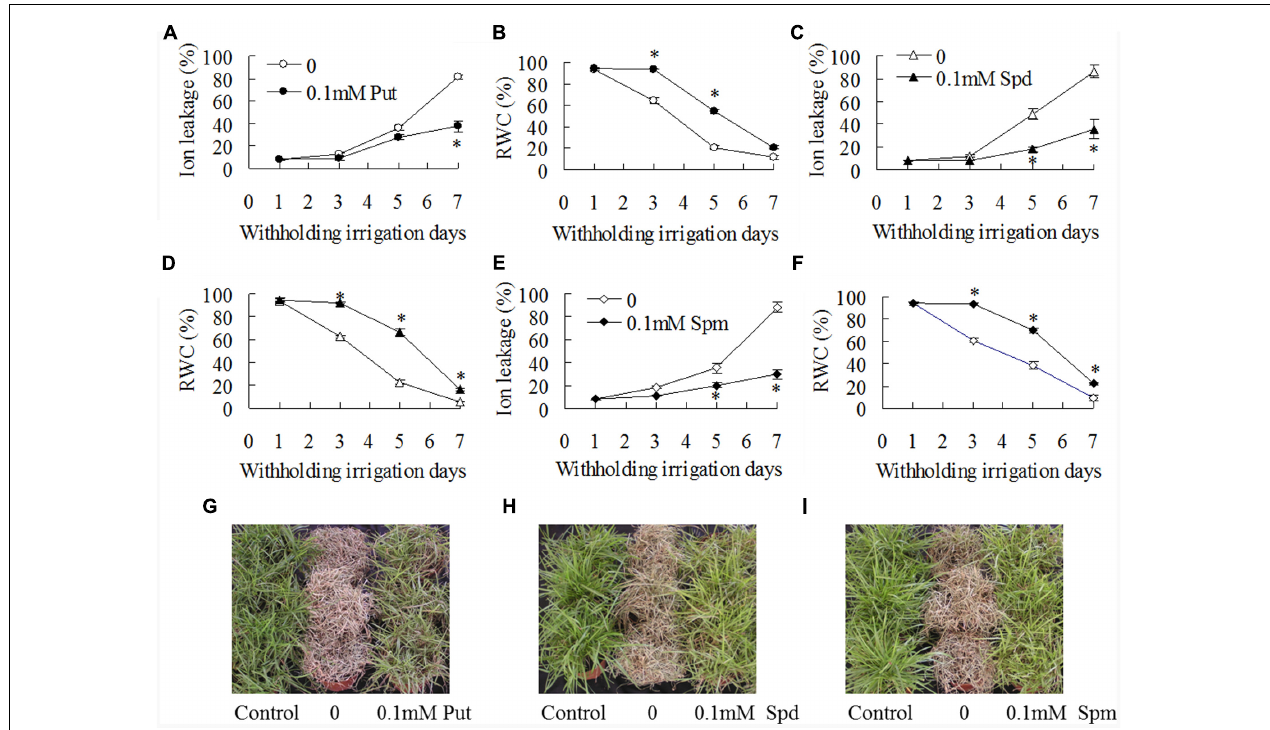
FIGURE 5 | Effects of exogenous putrescine (Put), spermidine (Spd), and spermine (Spm) on drought tolerance. The wild type (ZC1) plants were irrigated with 50 ml of 0.1 mM Put, Spd, or Spm solution per pot, followed by withholding irrigation. Ion leakage (A,C,E) and relative water content (B,D,F) were measured at the dates as indicated in the figures. Photography was taken after one week of recovery by re-watering plants post withholding irrigation (G–I) . Means of three independent plant samples and the standard errors are presented; an asterisk indicates significant difference between treatment with polyamines and untreated control at P < 0.05 at a given